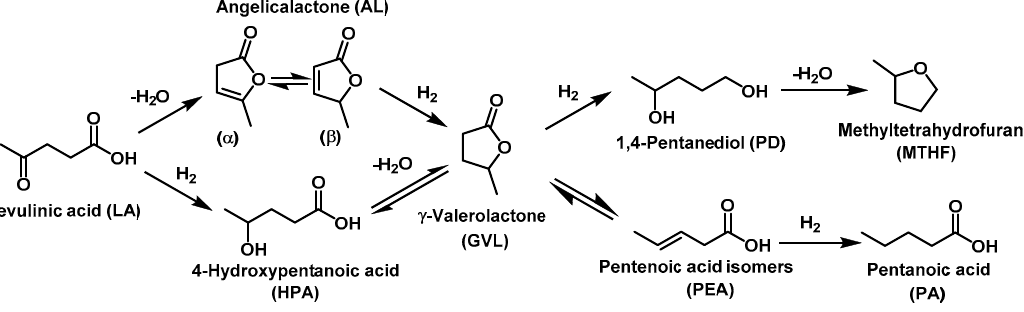
Figure 6. The possible pathways of hydrogenation of levulinic acid to γ -valerolactone.